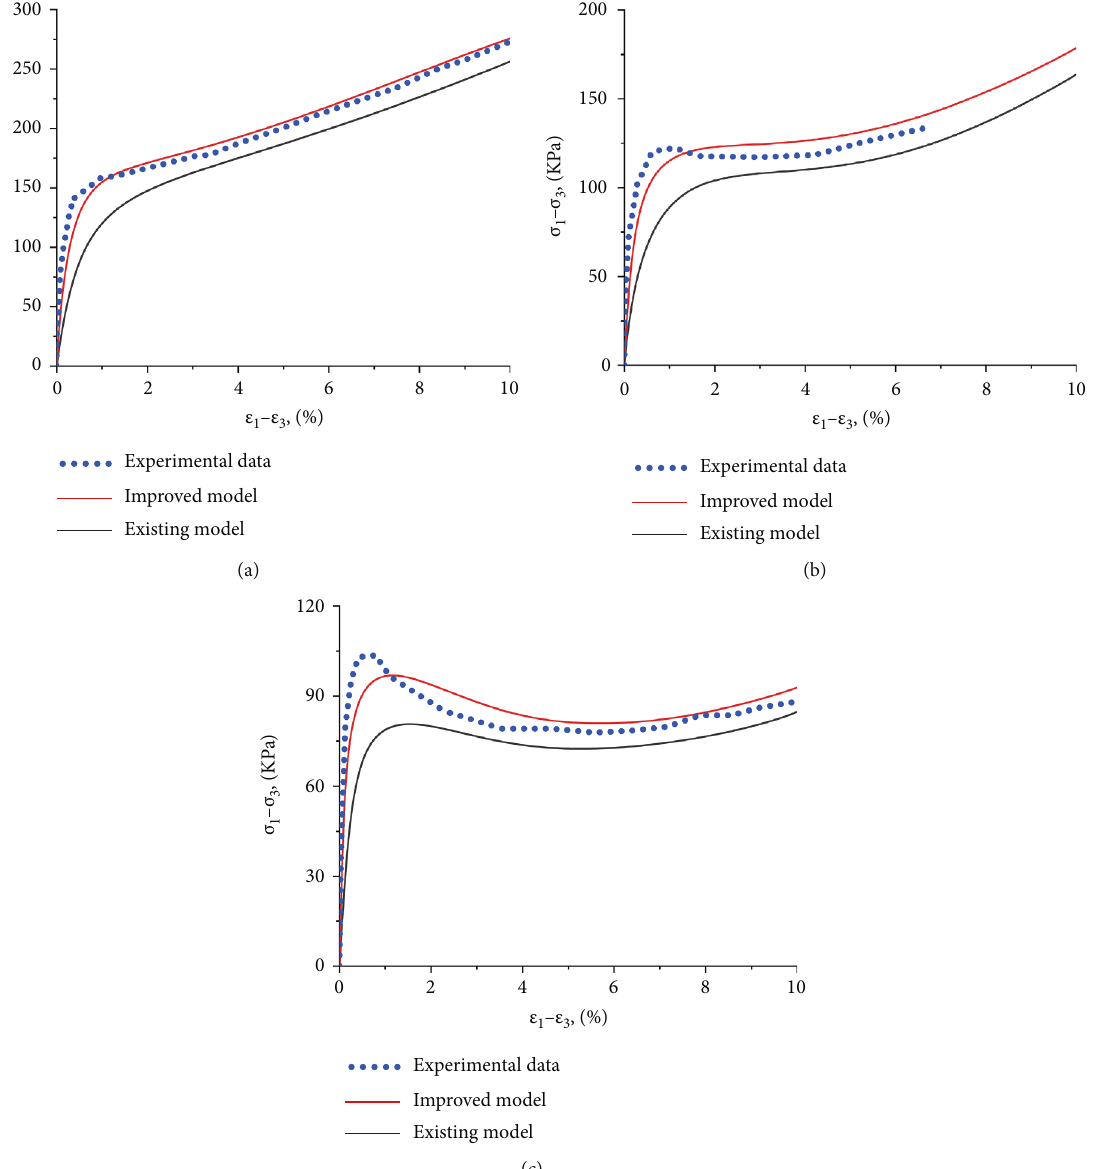
Figure 15: Comparison of two models and the experimental results by Uthayakumar and Vaid [50] for undrained triaxial tests (deviator stress-shear strain): (a) θ =0 ° ; (b) θ =30 ° ; (c) θ =60 °